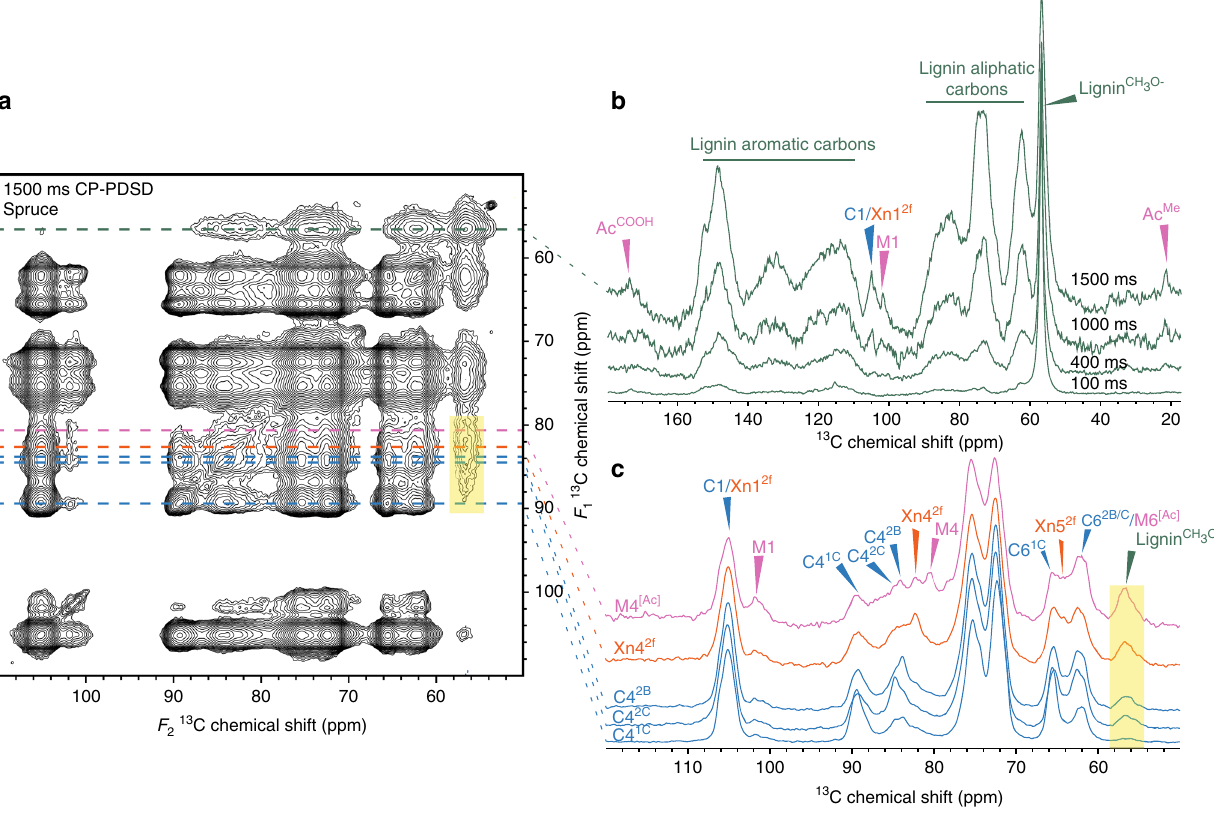
Fig. 5 Lignin is more intimately associated with GGM and xylan than cellulose in spruce. a The carbohydrate region of a 13 C MAS NMR 1500 ms mixing time CP-PDSD spectrum is shown, with lines drawn to mark where the 1D slices are derived from the 2D spectrum. b The lignin methoxyl (56.5 ppm) slice extracted from 2D CP-PDSD spectra at 100, 400, 1000 and 1500 ms mixing times are overlaid. The different spectra are normalised to the self-peak at 56.5 ppm. Cross-peaks between the lignin methoxyl and GGM acetate methyl and cellulose/xylan and GGM carbon 1 are labelled. c The carbon 4 slices of GGM (80.4 ppm), xylan (82.4 ppm) and three cellulose (2B = 83.7, 2C = 84.5, 1C = 89.5 ppm) sub-domains from the 1500 ms CP-PDSD spectrum are shown. Cross-peaks between the polysaccharides and the lignin methoxyl are labelled. All spectra are normalised so that the self-peak of carbon 4 is the same height. A translucent yellow box highlights the cross-peak to the lignin